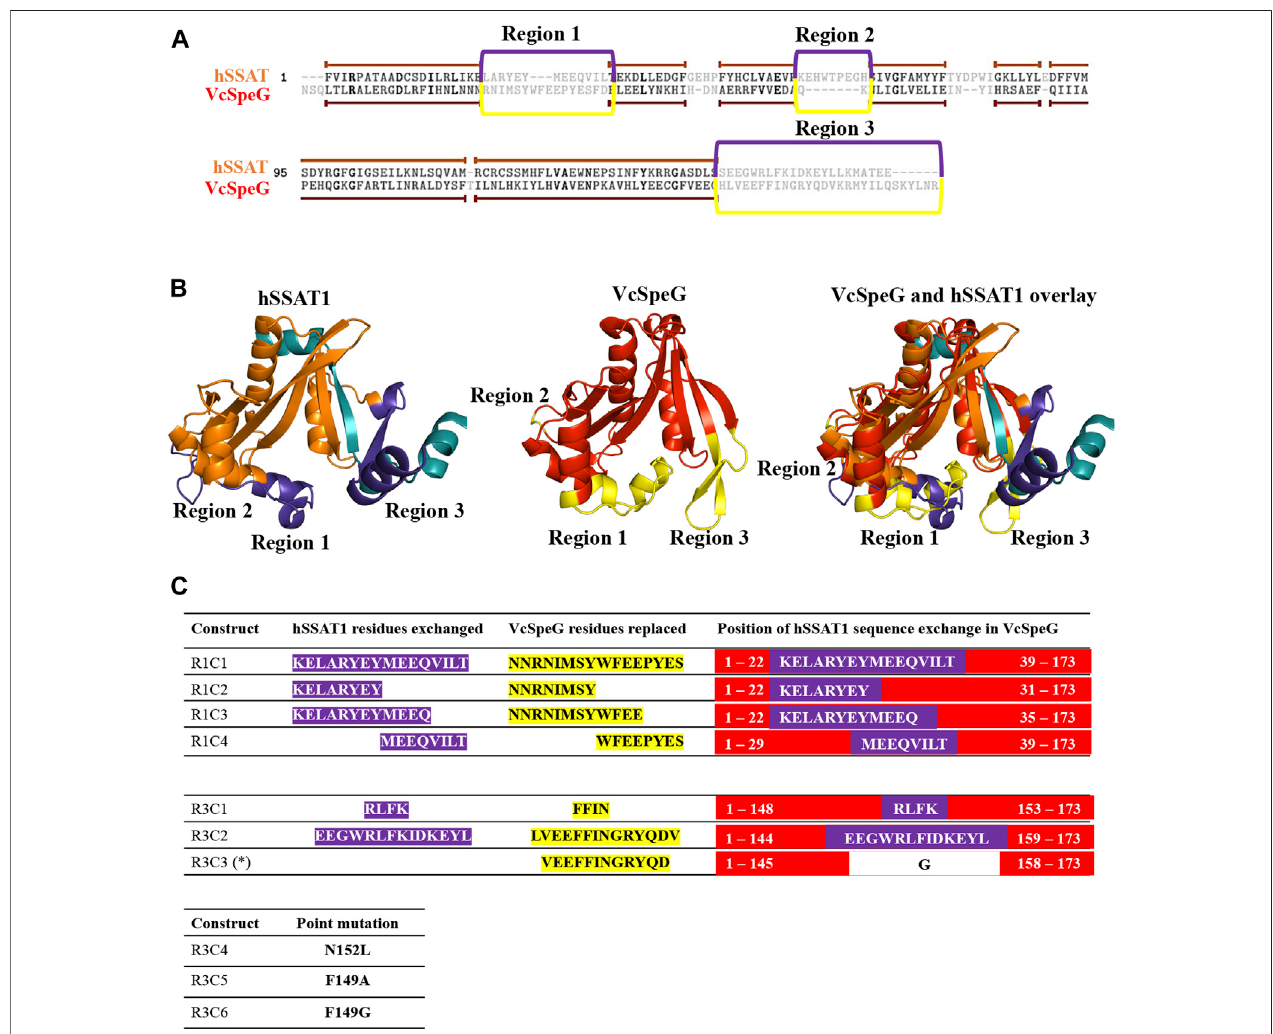
FIGURE 2 | Comparison of sequences and structures of VcSpeG and hSSAT1 and de fi ning regions and constructs for this study. A . Dissimilar regions between VcSpeG (PDB ID: 4r87) and hSSAT1 (PDB ID: 2b4b) structures shown on a primary sequence alignment generated using TopMatch. Gray residues framed in purple (hSSAT1) and yellow (VcSpeG) show unaligned regions ofthe structures during structural alignment.We named these regionsofstructuralvariabilityin sequential order. B .ThreedifferentregionshighlightedonthemonomerVcSpeGandhSSAT1structures.AllthreeregionsareshowninpurpleonthehSSAT1structure(orange);the teal secondary structure shown is from the adjacent monomer of the dimer. Only the complete monomer is shown for clarity. Similarly, all three regions of the VcSpeG protein monomer (red) are highlighted in yellow. C. Construct names and residues substituted or altered in the ten VcSpeG constructs for this study. Residues highlighted in yellow are removed from VcSpeG and replaced by hSSAT1 residues in purple. The position of hSSAT1 exchange on each VcSpeG cartoon linear protein sequence is also shown. An asterisk indicates the deletion construct.